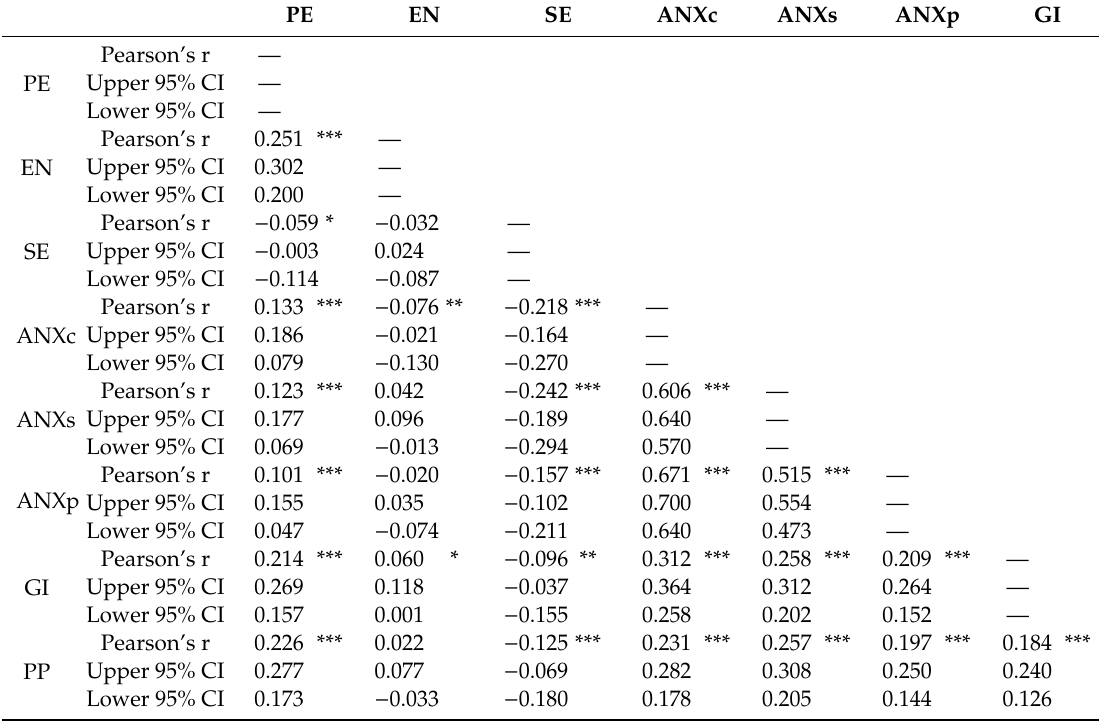
Table 1. Bivariate